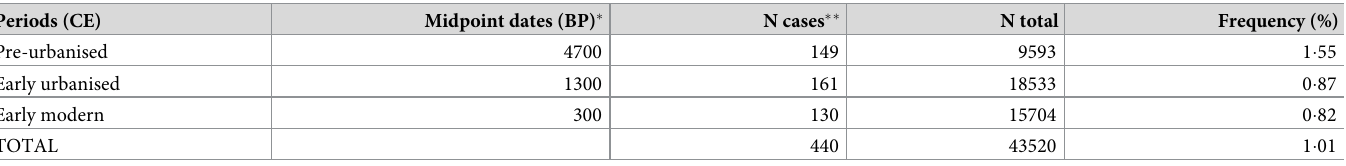
Table 1. Frequency of bone signs of tuberculosis in consecutive periods of human history. Periods (CE) Midpoint dates (BP) � N cases �� N total Frequency (%) Pre-urbanised 4700 149 9593 1 � 55 Early urbanised 1300 161 18533 0 � 87 Early modern 300 130 15704 0 � 82 TOTAL 440 43520 1 � 01 Chi squared = 37.92 (p < 0.0001), Cramer’s V =